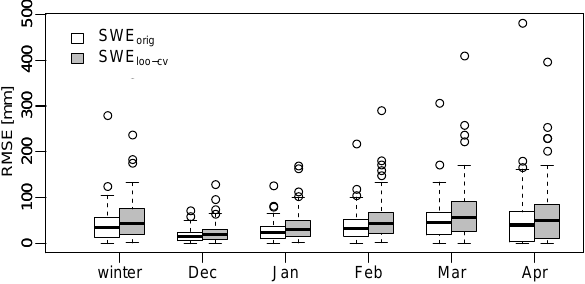
Fig. 3. The effects of season on the root-mean-squared error (RMSE) over the period 2001–2009. White boxes contain the scores for all stations calculated with SWE orig and the grey boxes those based on SWE loo-cv